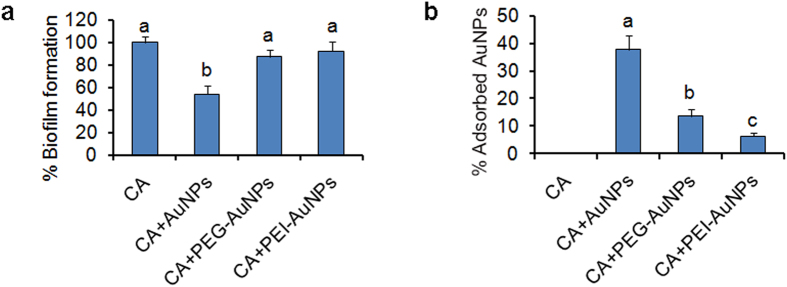
Effect of PEG/PEI coating on inhibition of AuNPs to biolfilm formation and C. albicans-AuNPs adsorption.(a) C. albicans biofilms were formed in RPMI 1640 medium (CA) or the medium containing 5 ppm of AuNPs (CA + AuNPs), PEG-AuNPs (CA + PEG-AuNPs) or PEG-AuNPs (CA + PEI-AuNPs) for 24 h, and the formed biofilms were assessed by the XTT reduction method. (b) The formed biofilms were scraped from the microplate bottom and suspended in the previous culture medium. The suspensions were then filtered, and the filtrates were used to determine Au contents by ICP. The error bars indicate one standard deviations (n = 3). Identical letters indicate no statistical differences among treatments (P < 0.05).